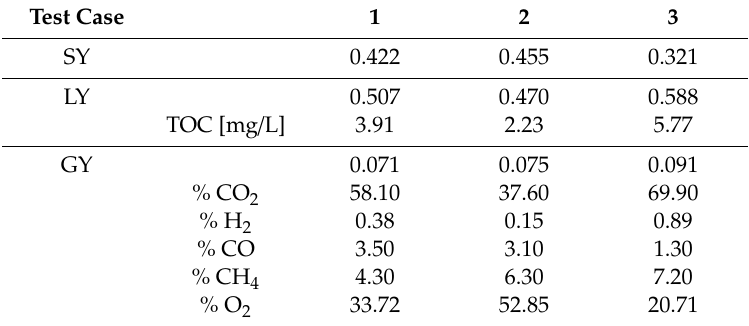
Table 2. Mass yields, gas compositions and TOC obtained experimentally in